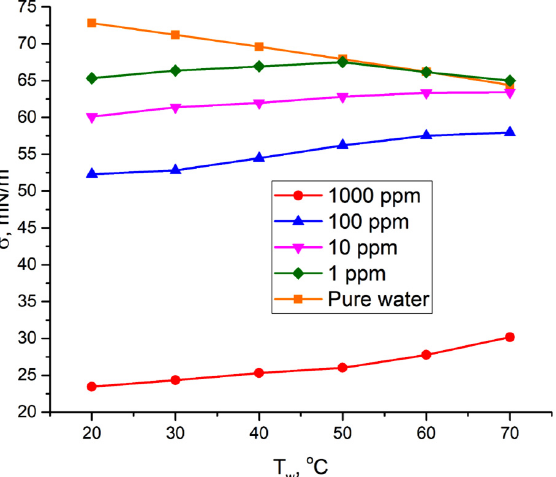
Figure 3. Surface tension vs. temperature for different concentrations of SLS in aqueous solutions.